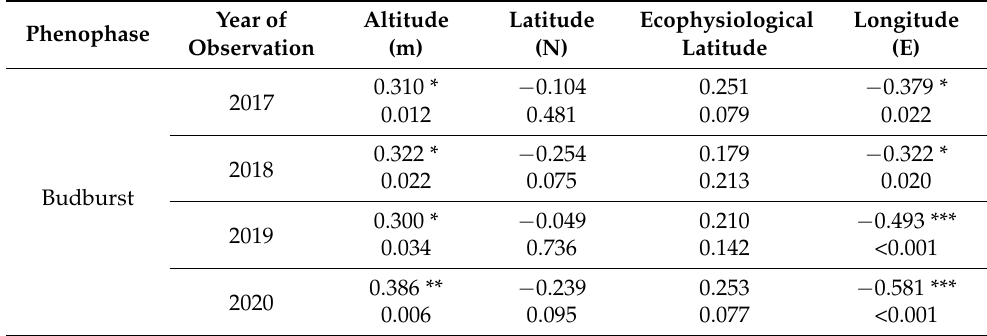
Table 5. Spearman’s rank correlation coefficients and their significance levels between phenophases and the geographical gradients of the